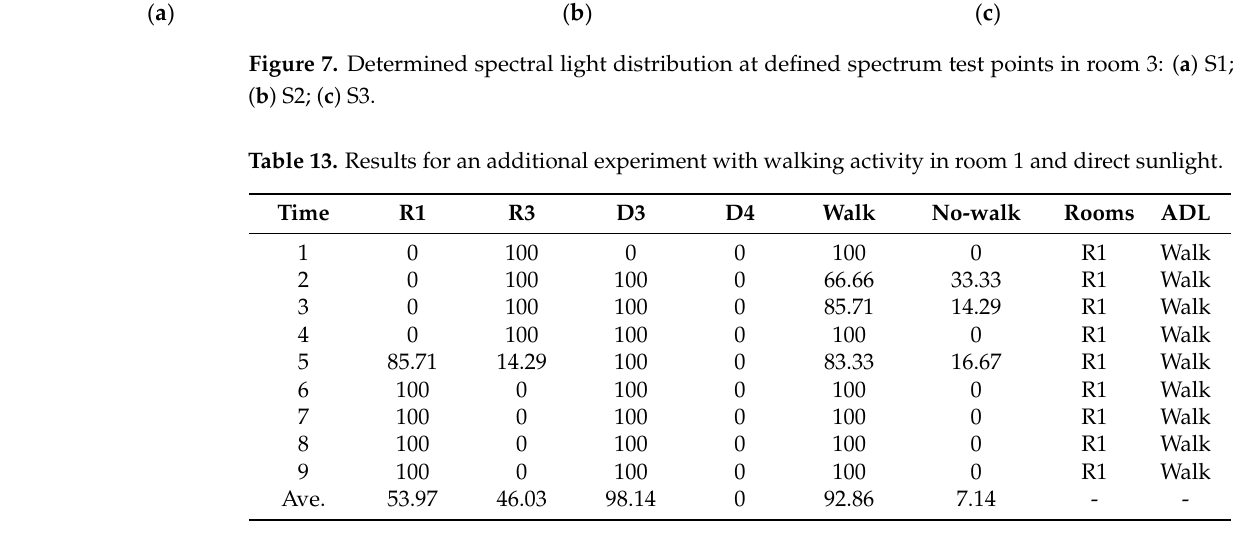
Table 13. Results for an additional experiment with walking activity in room 1 and direct sunlight.